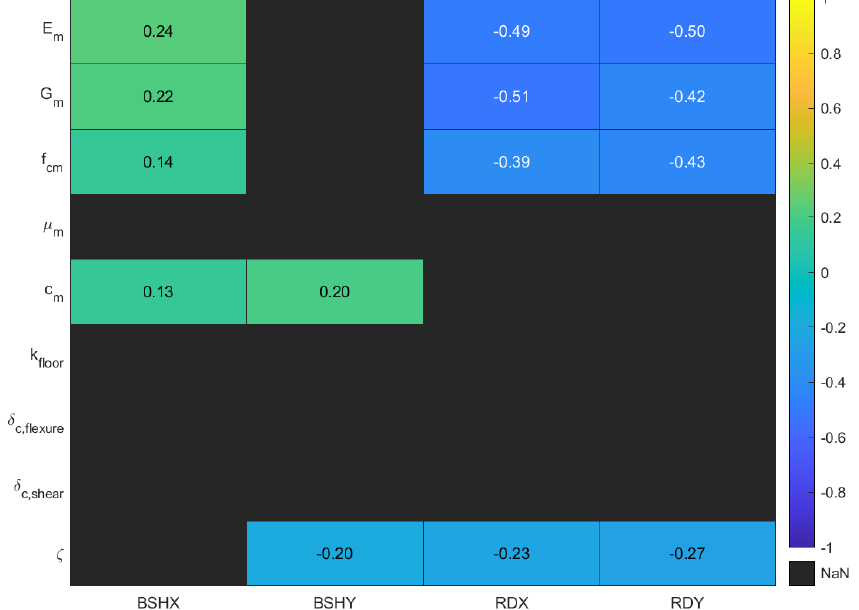
Figure 13. Holsteiner Hof model (with out-of-plane disabled and rigid connections) Spearman correlation matrix for PGA 0.21